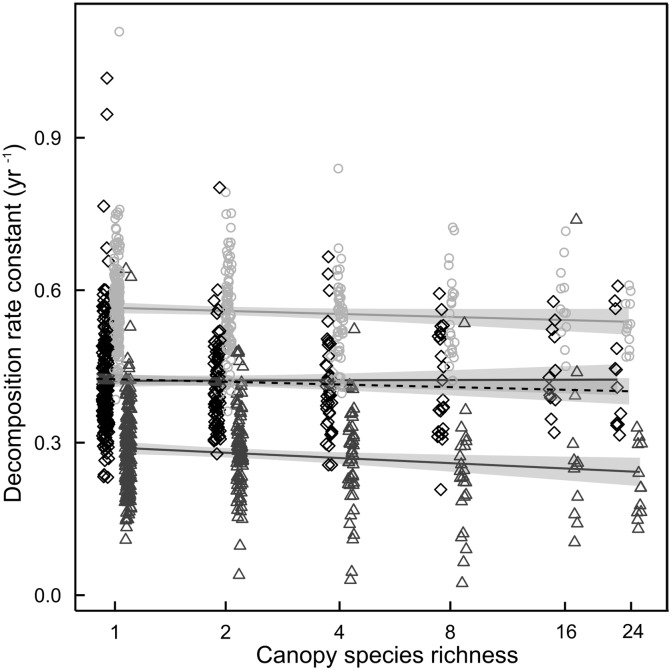
Leaf litter decomposition rate constants of Osmanthus fragrans (circles), Schima superba (squares) and Pinus massoniana (triangles) in dependence of stand tree species diversity.The predicted means and confidence intervals for the respective tree species are represented by the continuous lines while the mean for all three species is represented by the dashed line.